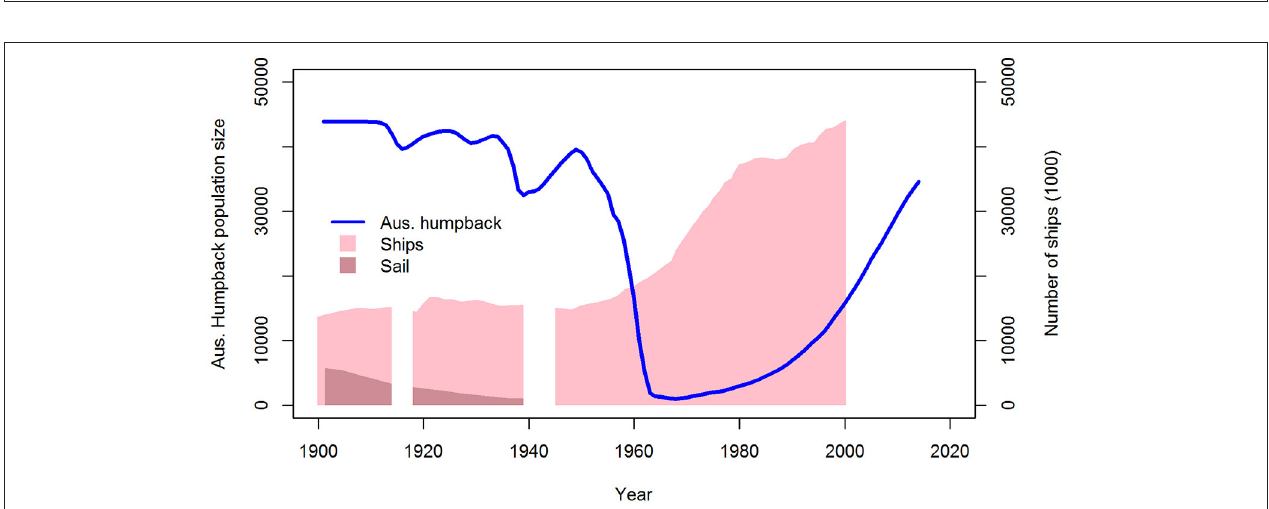
FIGURE 5 | General estimated population trajectory for Australian humpback whales compared to worldwide commercial ship numbers. Humpback population given as blue line data from Jackson et al. (2015), vessel numbers (shown in pink) based on Lloyd’s Register of Ships (Endresen et al., 2007).